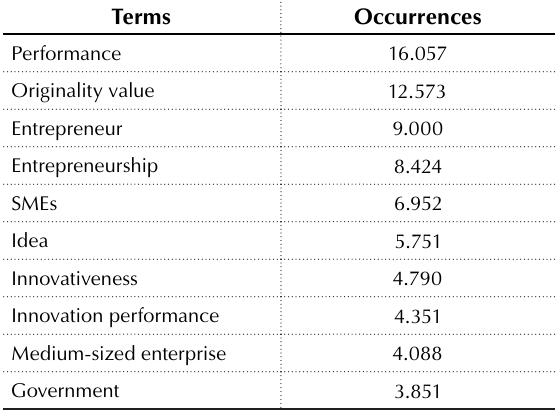
Table 2. List of 10 most frequently occurring terms in studies of innovation management in business